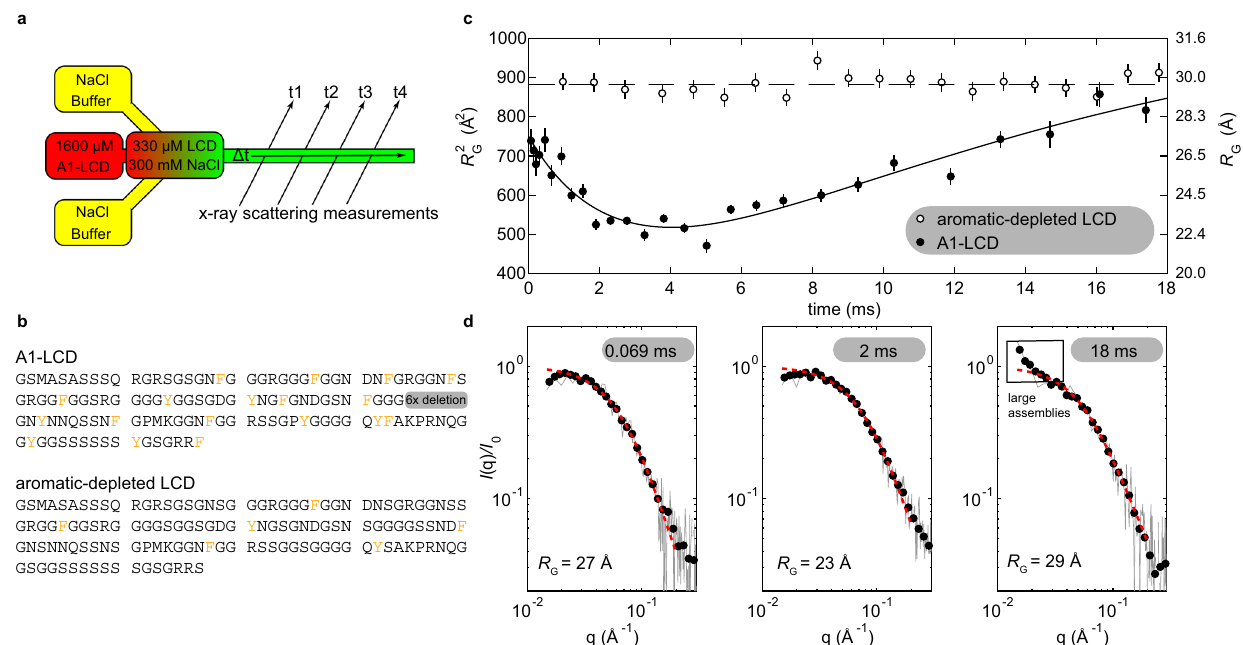
Fig. 3 Chaotic- fl ow time-resolved SAXS experiments reveal the collapse of A1-LCD before its assembly. a A schematic showing the mixing of A1-LCD (initially without excess salt in the one-phase regime, red) with NaCl-containing buffer (yellow). The resulting solution is in the two-phase regime (green). b The amino acid sequences of A1-LCD and the aromatic-depleted LCD. Aromatic amino acid residues are colored orange. c R G and R G 2 of the A1-LCD (black) and an aromatic-depleted variant of the A1-LCD (open circles). The R G values are calculated by fi tting the IDR form factor to data binned for 6 consecutive frames. The solid line is a fi t to the sum of exponential collapse ( τ ~ 470 μ s) and growth ( τ ~ 36 ms) (Supplementary Eq. 1). The dashed line is a horizontal line at the mean value for the aromatic-depleted variant. Error bars represent the standard error in the fi t to the IDR form factor. d Individual SAXS curves from points along the time course shown in b . Raw curves were selected to represent the initial state after full mixing, the minimum R G , and the end of the observable time window. Black dots are data logarithmically smoothed into 30 bins, gray lines are raw data, and red dashed lines are fi ts to the IDR form factor from which R G was extracted. The boxed region at 18 ms highlights the departure of the form factor at small angles from a monomer and thus indicates beginning assembly, beyond which point we stop reporting R G